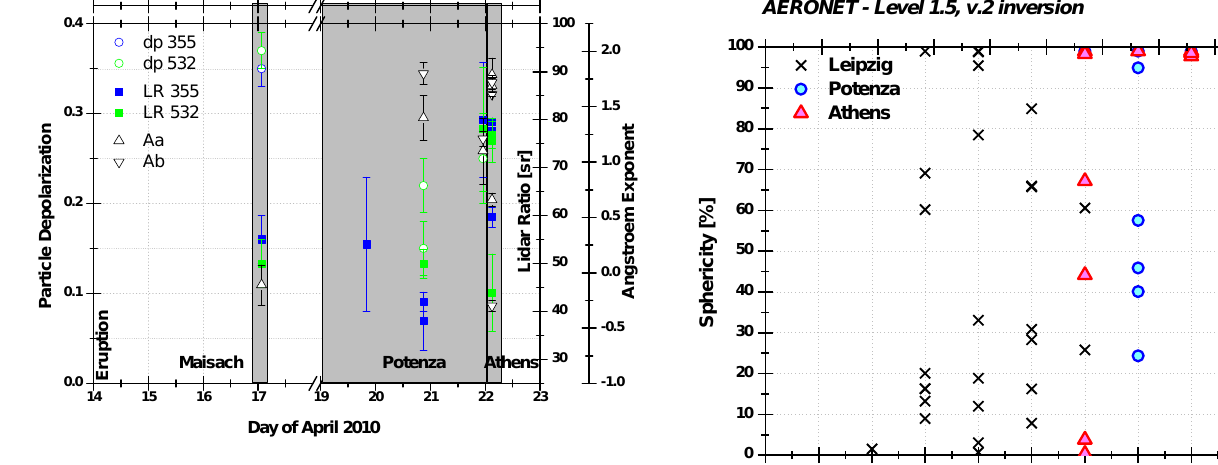
Fig. 9. Aerosol optical properties (depolarization ratio, S , extinction and backscatter-related Ångström exponent) from various studies of the inside of volcanic aerosol layers, as obtained over Maisach, Germany (Gross et al., 2011); Potenza, Italy (Mona et al., 2012a); and Athens, Greece (present study), from 17 to 23 April 2010.